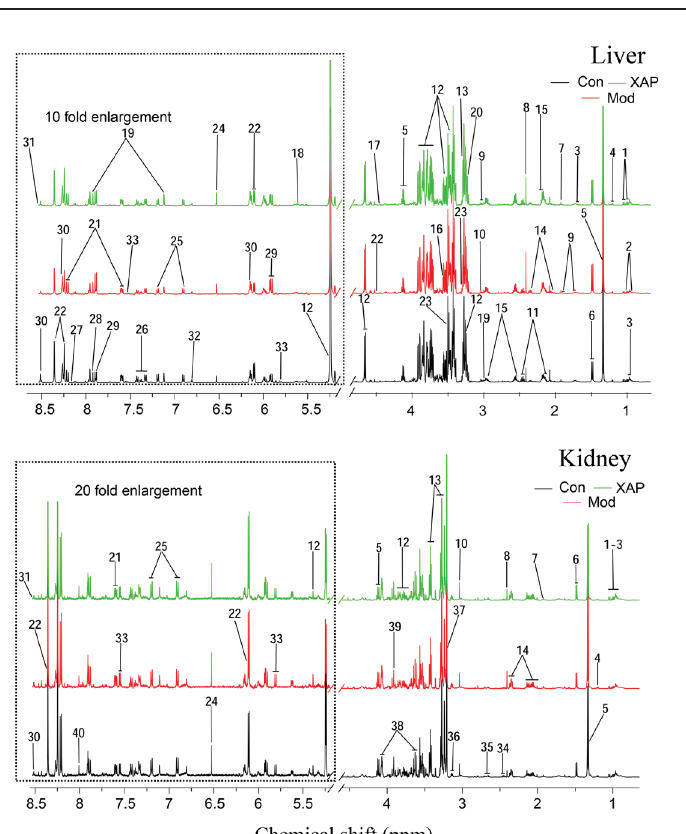
FIGURE 3 - Fold change plots color-coded with p-values adjusted by Benjamini Hochberg method indicating the significance of altered metabolites in the liver of (A), XAP vs. control (B), model vs. control (C), and lung of XAP vs. control (D), model vs. control. The blue and red dashed lines represented variations of 20% and 100%, respectively.